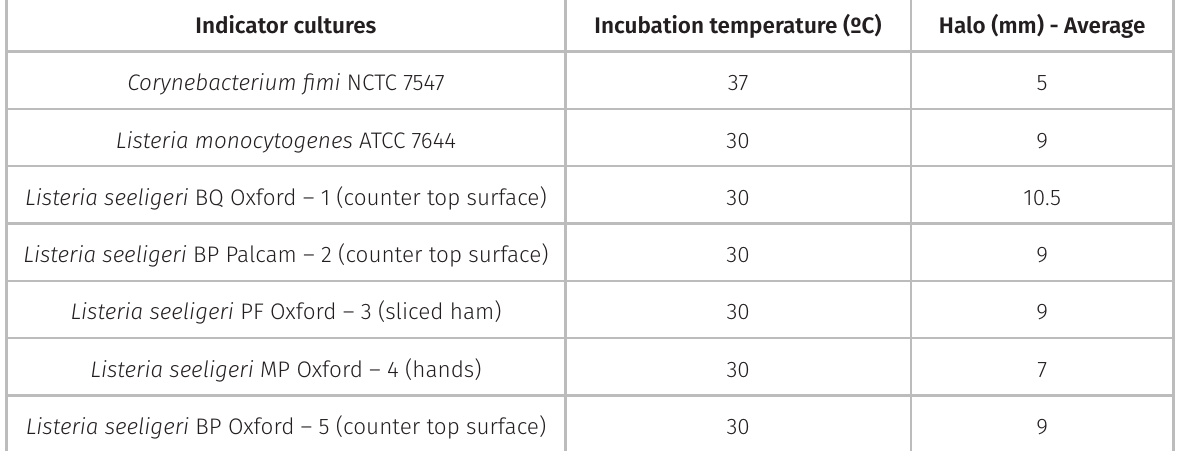
Table IV. Antimicrobial spectrum of crude supernatant from Bacillus sp. sed 2.2. Indicator